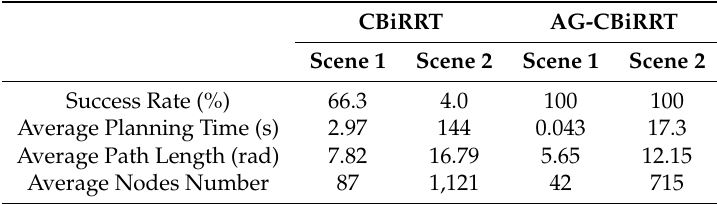
Table 2. Dual-arm robot motion planning under task